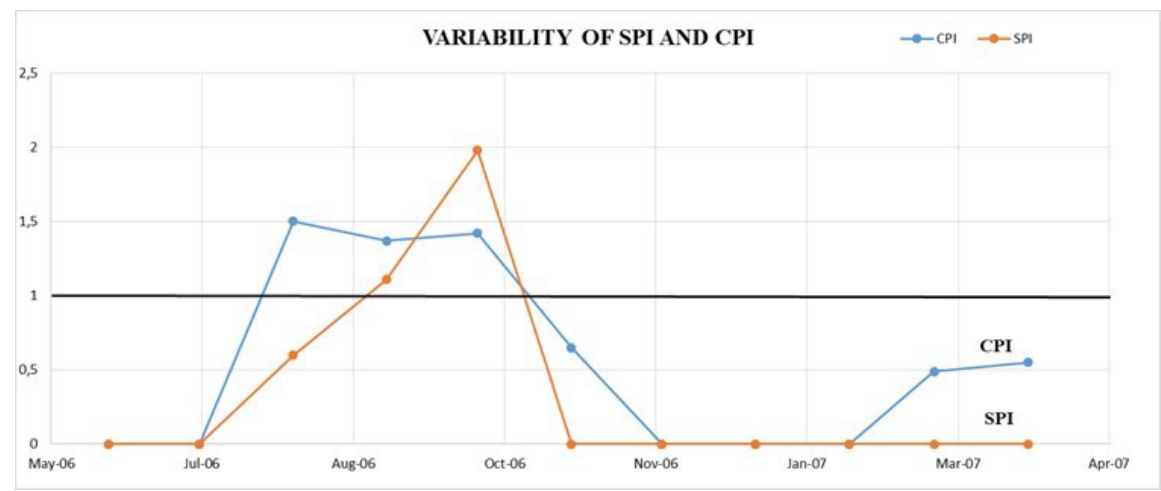
Figure 5: Variability of SPI and CPI [authors’